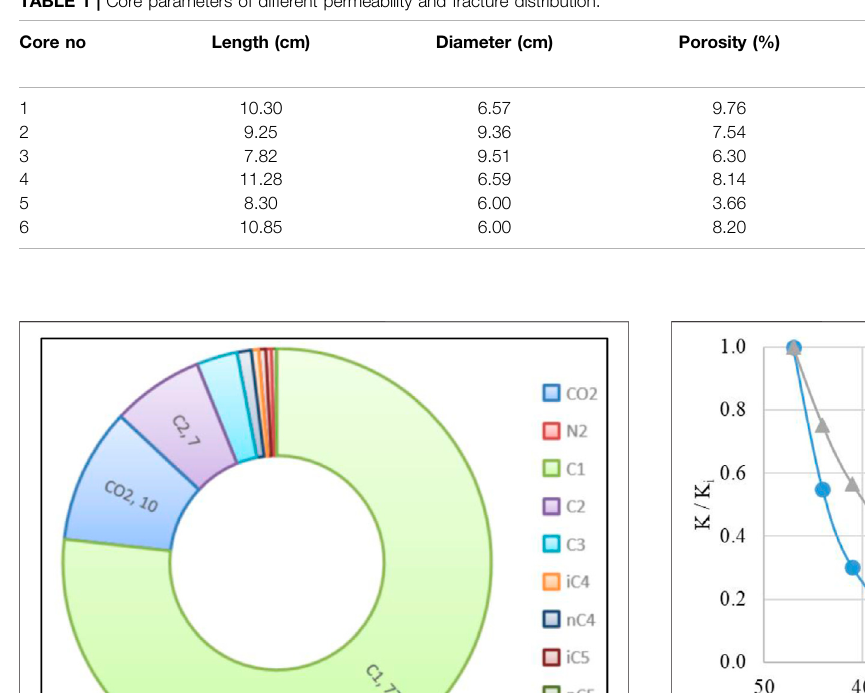
TABLE 1 | Core parameters of different permeability and fracture distribution.